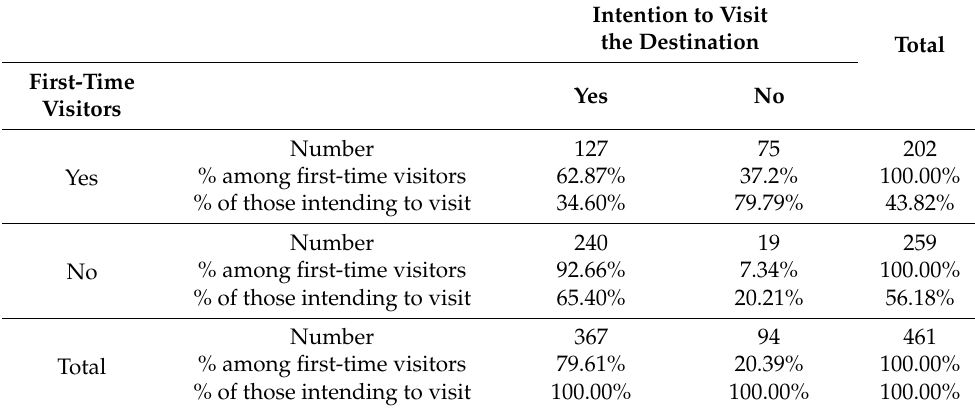
Table 1. Crosstabulation of variable intention to visit the destination.